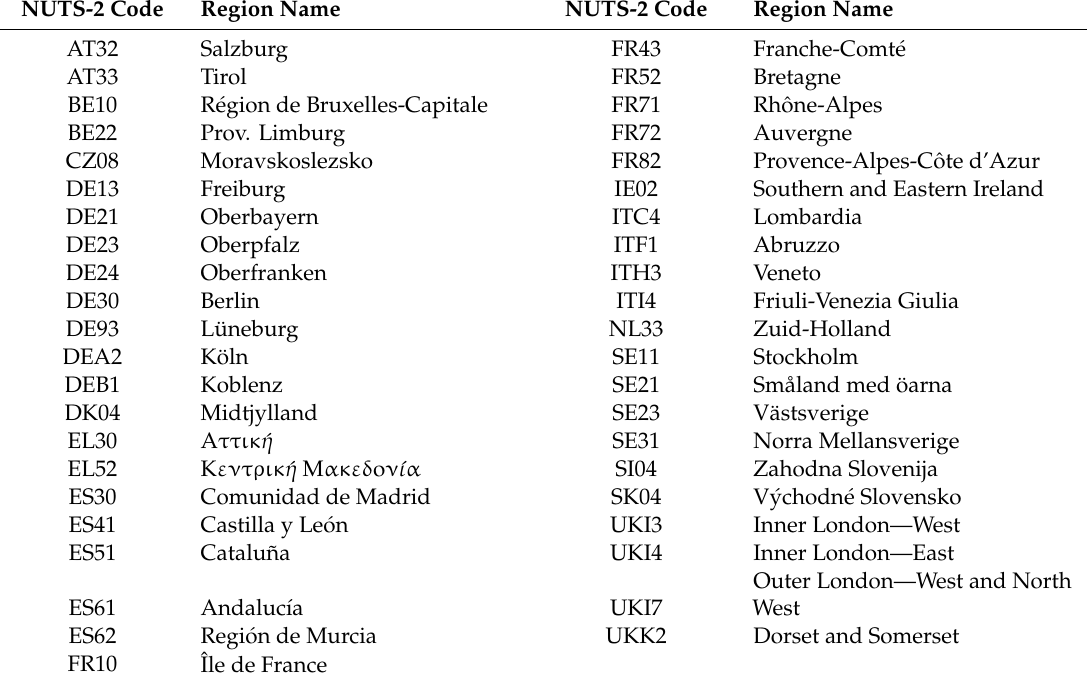
Figure A8. Sectoral specialisation of regions (natural breaks). Table A3. Region codes (selected)